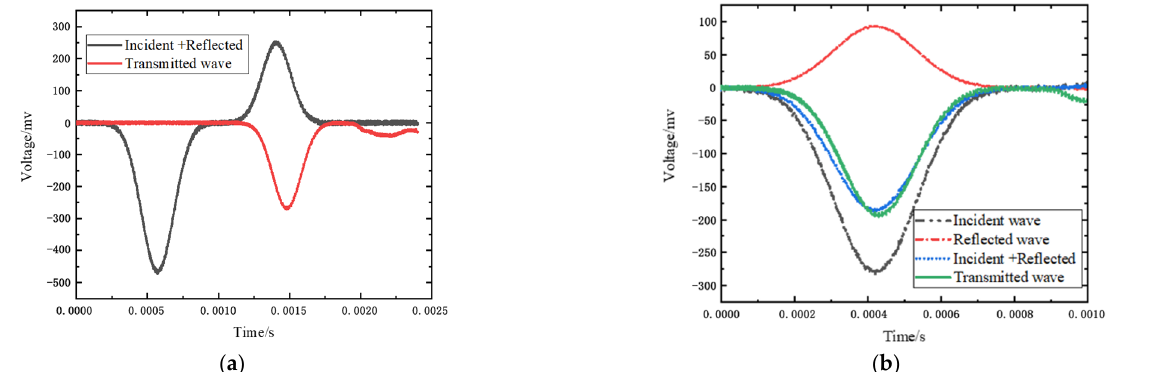
Figure 4. Original stress wave. ( a ) SHPB test collection wave. ( b ) The three waves graph.